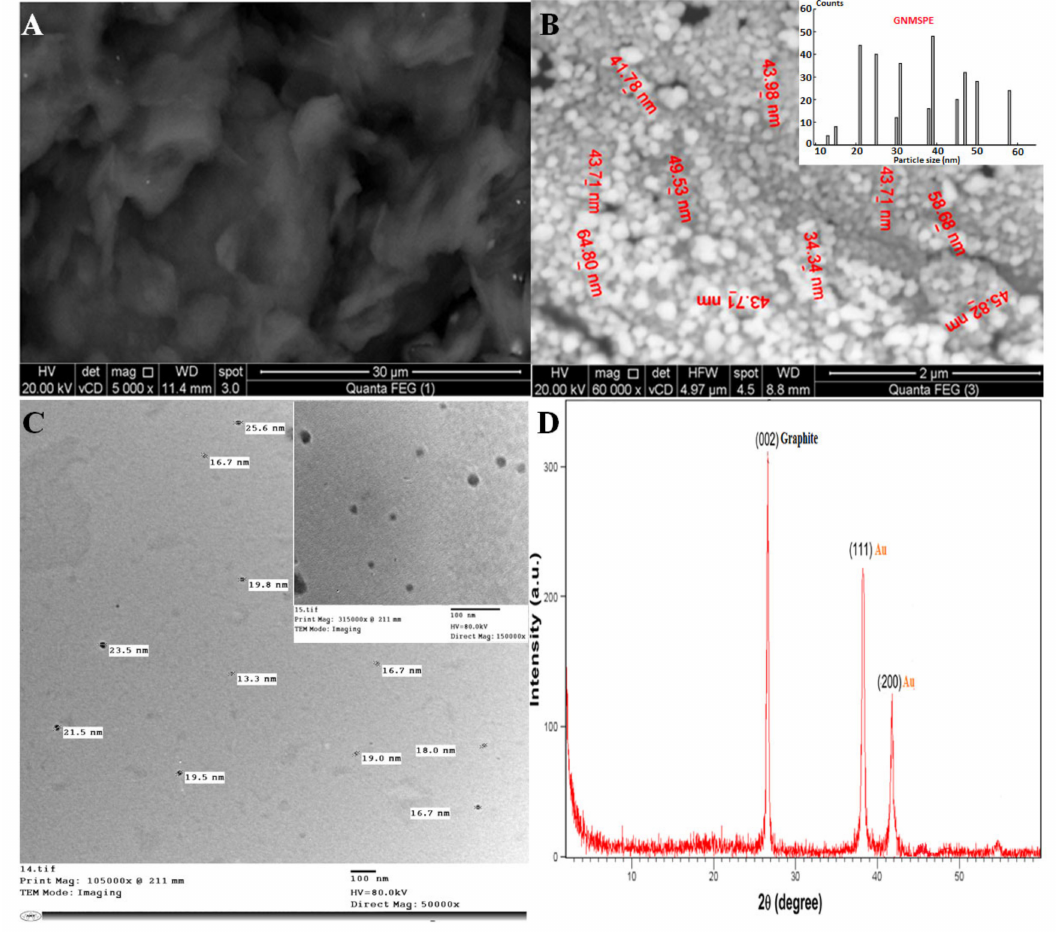
Figure 1. Scanning electron microscopy (SEM) micrographs of the screen-printed electrode surfaces ( A : screen-printed electrode (SPE) and B : gold nanoparticles modified SPE (GNMSPE) accompanied with its histogram); ( C ) transmission electron microscopy (TEM) micrograph of Au nanoparticles; and, ( D ) XRD pattern of